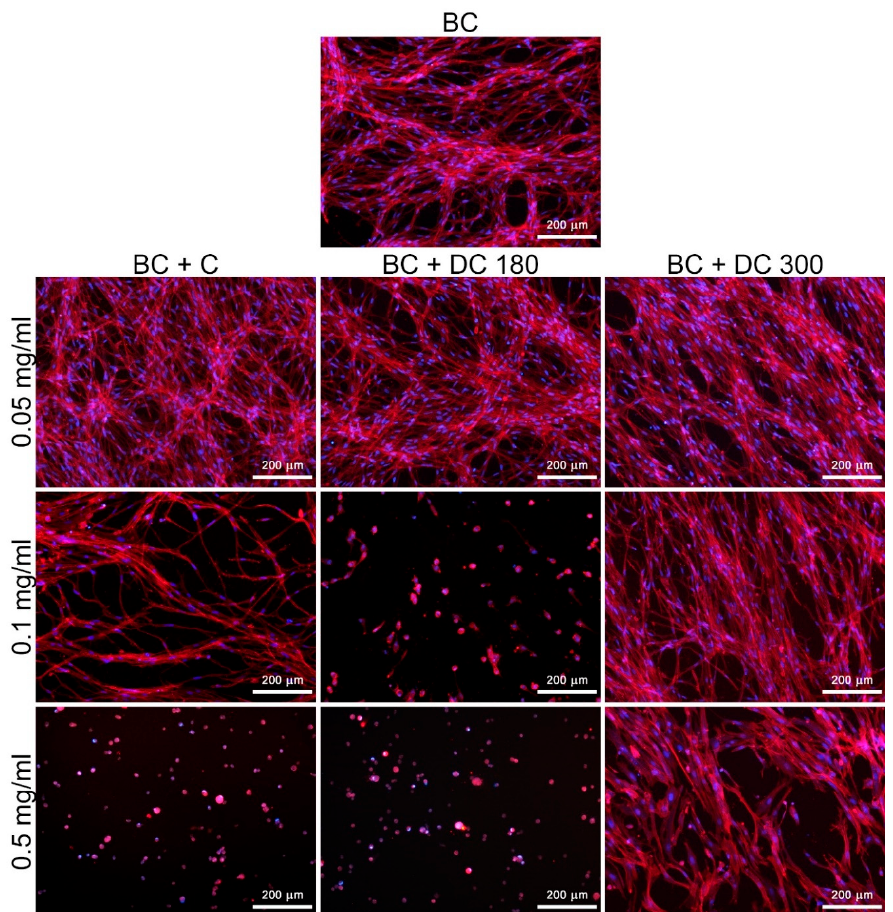
Figure 8. Morphology of human dermal fibroblasts on pristine bacterial nanocellulose (BC) and on nanocellulose loaded with pure curcumin (BC + C), or with curcumin degraded at 180 °C (BC + DC 180) or at 300 °C (BC + DC 300) at various concentrations (0.05, 0.1, and 0.5 mg/mL) on day 7 after cell seeding. The cells were stained with phalloidin-TRITC (red; F-actin cytoskeleton) and with DAPI (blue; cell nuclei). Olympus IX 51 microscope, obj. 10×, DP 70 digital camera.